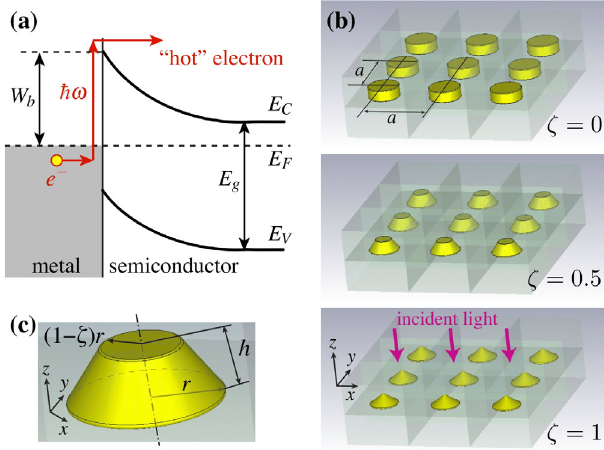
FIG. 1. Schematics of (a) “ hot ” photoelectron emission through the Schottky barrier at a metal-semiconductor interface; (b) sev- eral nanoparticle arrays studied in the present paper (showing three characteristic cases of cylinders, truncated cones, and cones); (c) enlarged view of one nanoparticle showing its geometrical